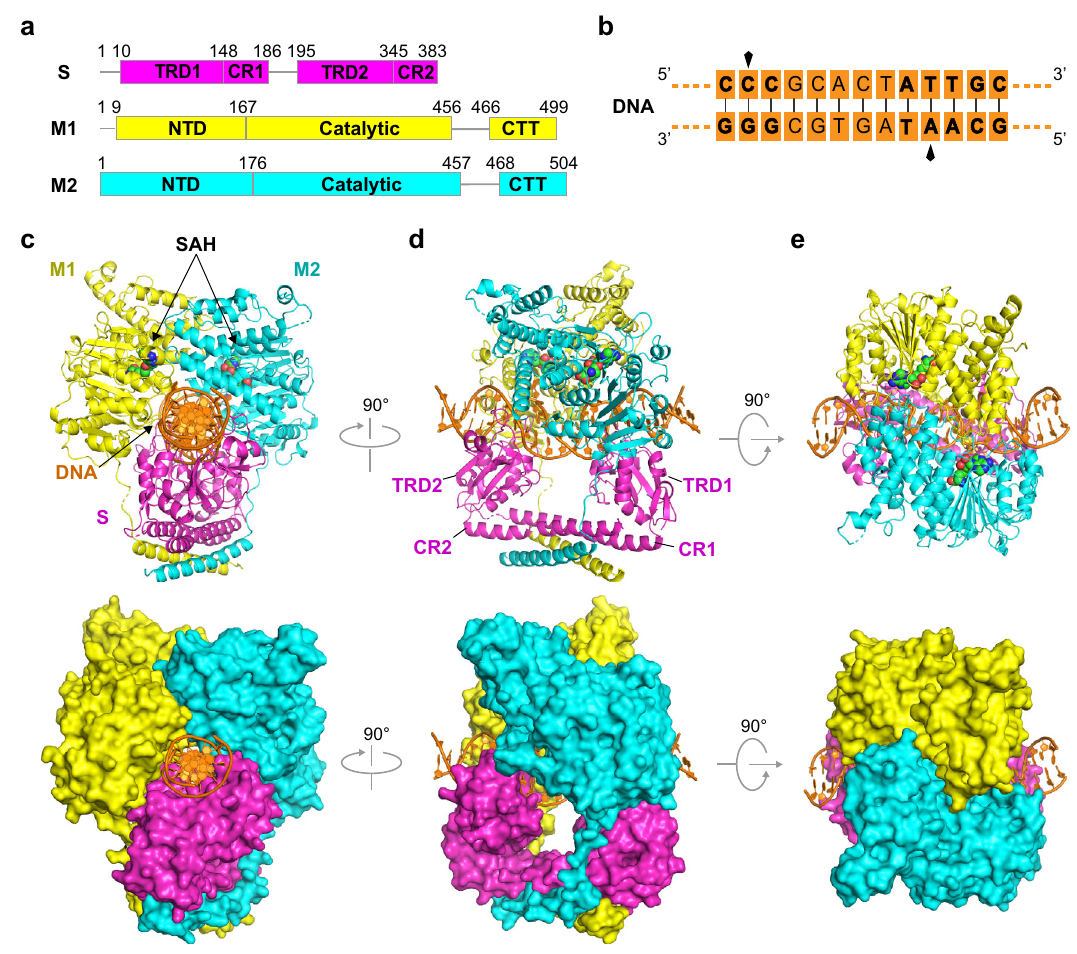
Fig.1|OverallstructureofPacII_M1M2Sheterotrimercomplexboundtotarget DNA and SAH. a Domain organization of S, M1, and M2 subunits of PacII MTase, with domain boundarylabeled accordingto thiswork. b Schematicrepresentation of the target DNA used for co-crystallization. The bipartite recognition motifs (5'- CCC-3' and 5'-GCAAT-3') are shown in bold with the cytosine and adenine for